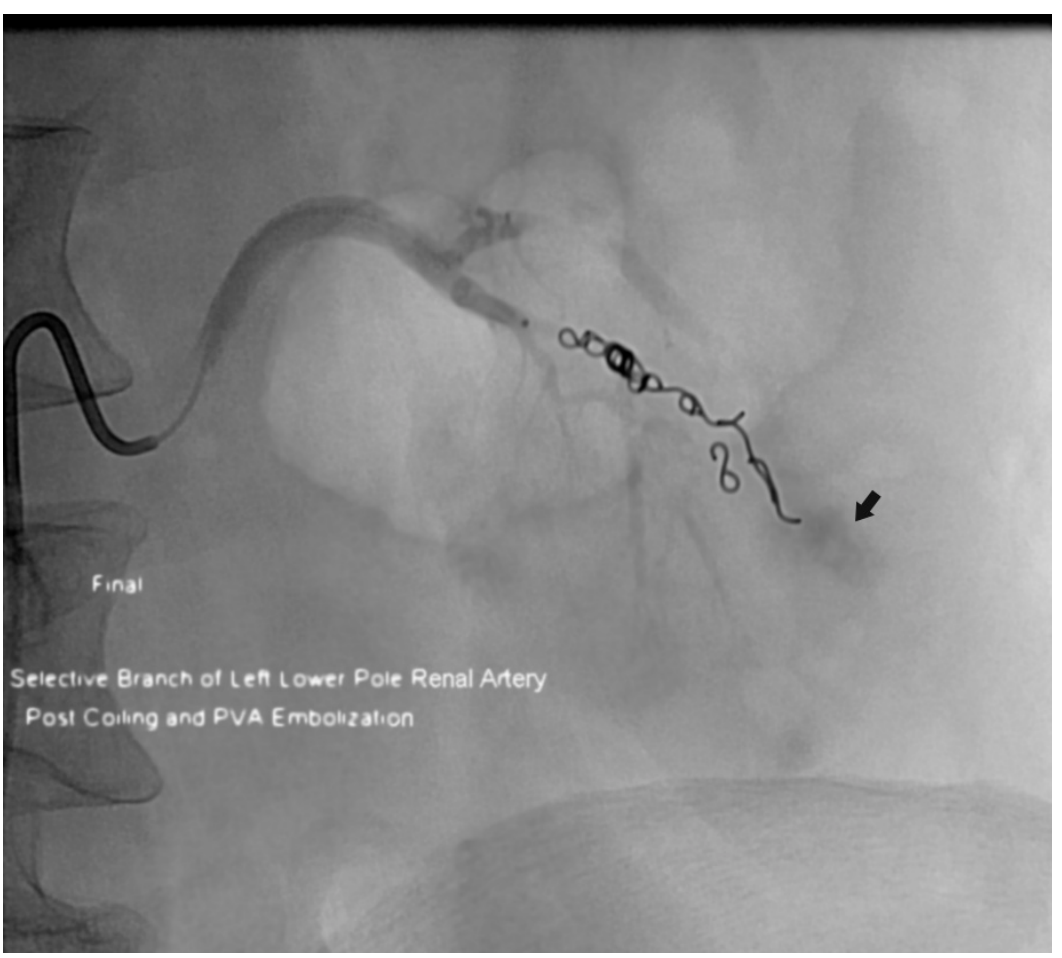
Figure 1. Patient who had active bleeding after an ultrasonographically-guided left native kidney biopsy. This image is from the postprocedure arteriogram after coil and particle embolization of a lower pole renal artery branch. Residual extravasated contrast material is still evident (arrow). The patient was receiving a subcutaneous low-molecular-weight heparin bridge, with the last dose given approximately 6 h before the procedure.